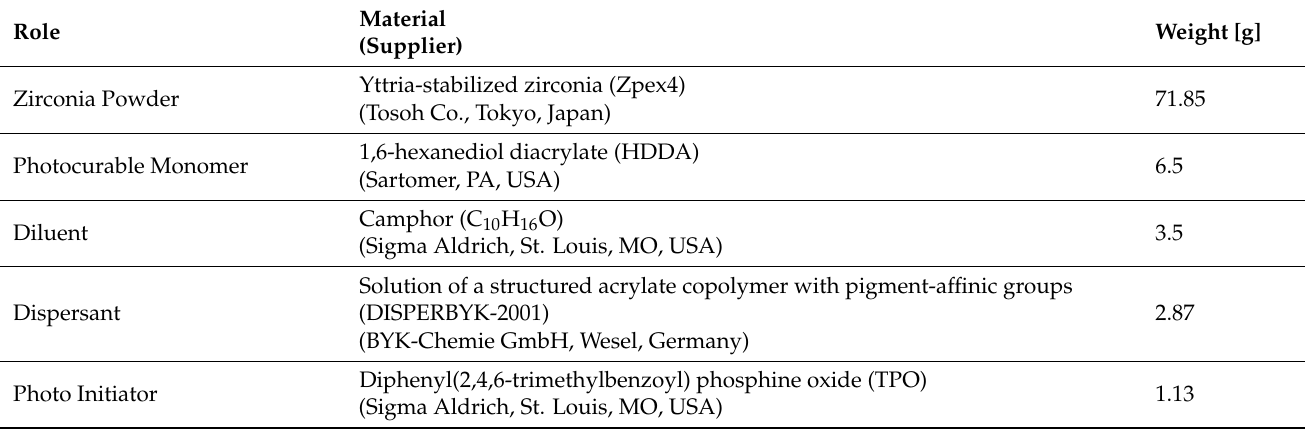
Table 1. Constituents of zirconia suspensions prepared using an HDDA–camphor solution as a liquid vehicle for DLP